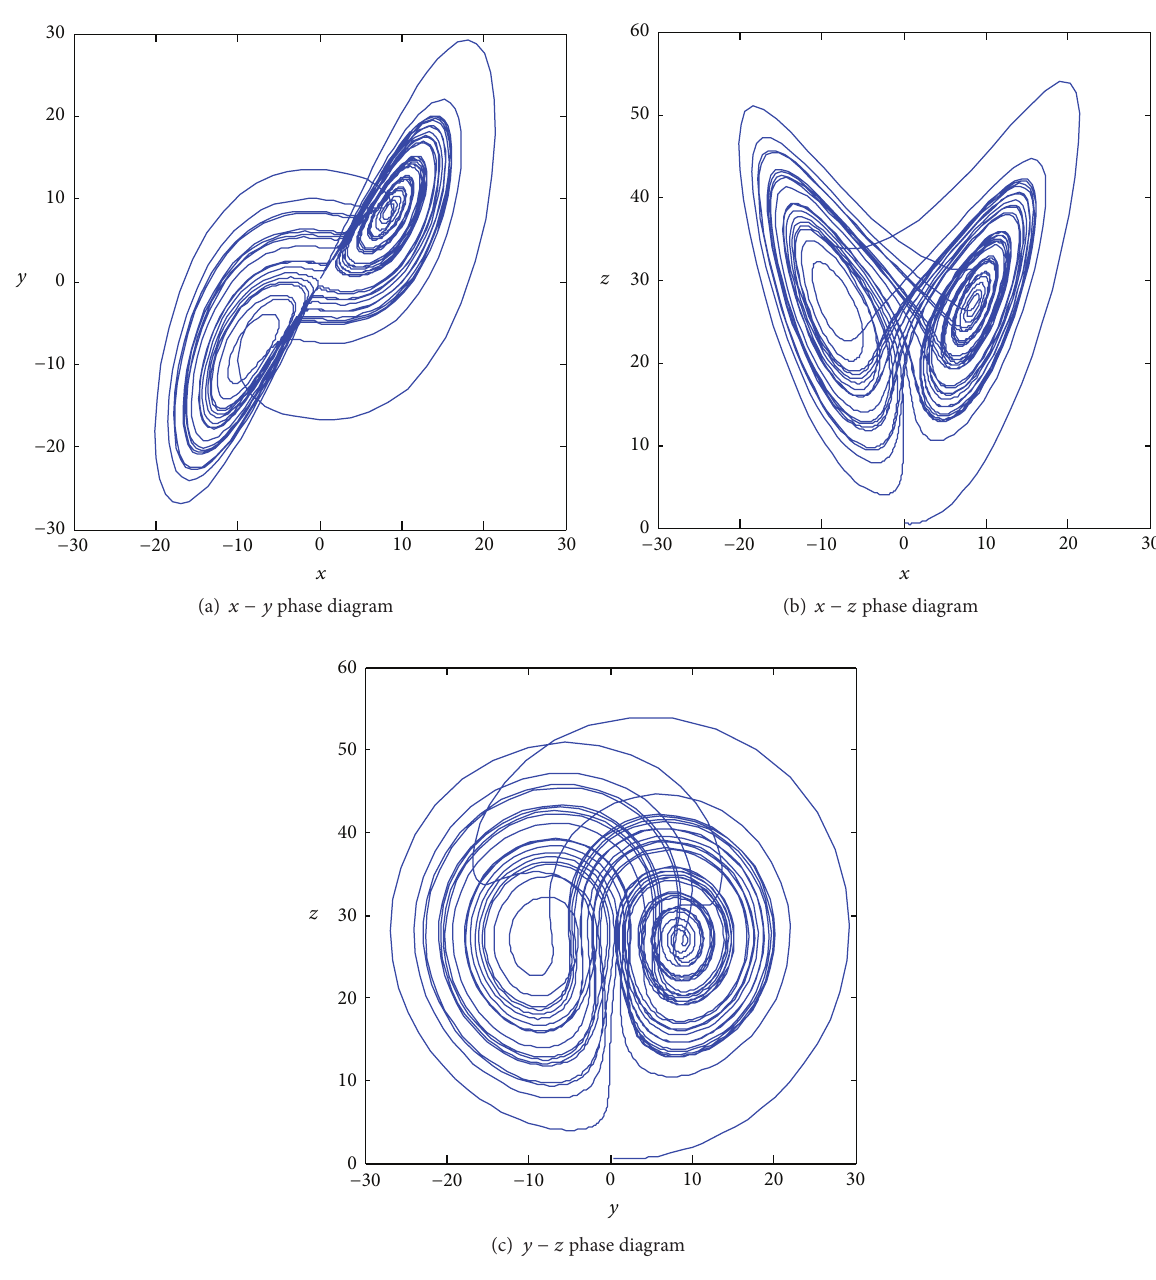
Figure 2: Phase diagrams of the improved Lorenz chaotic